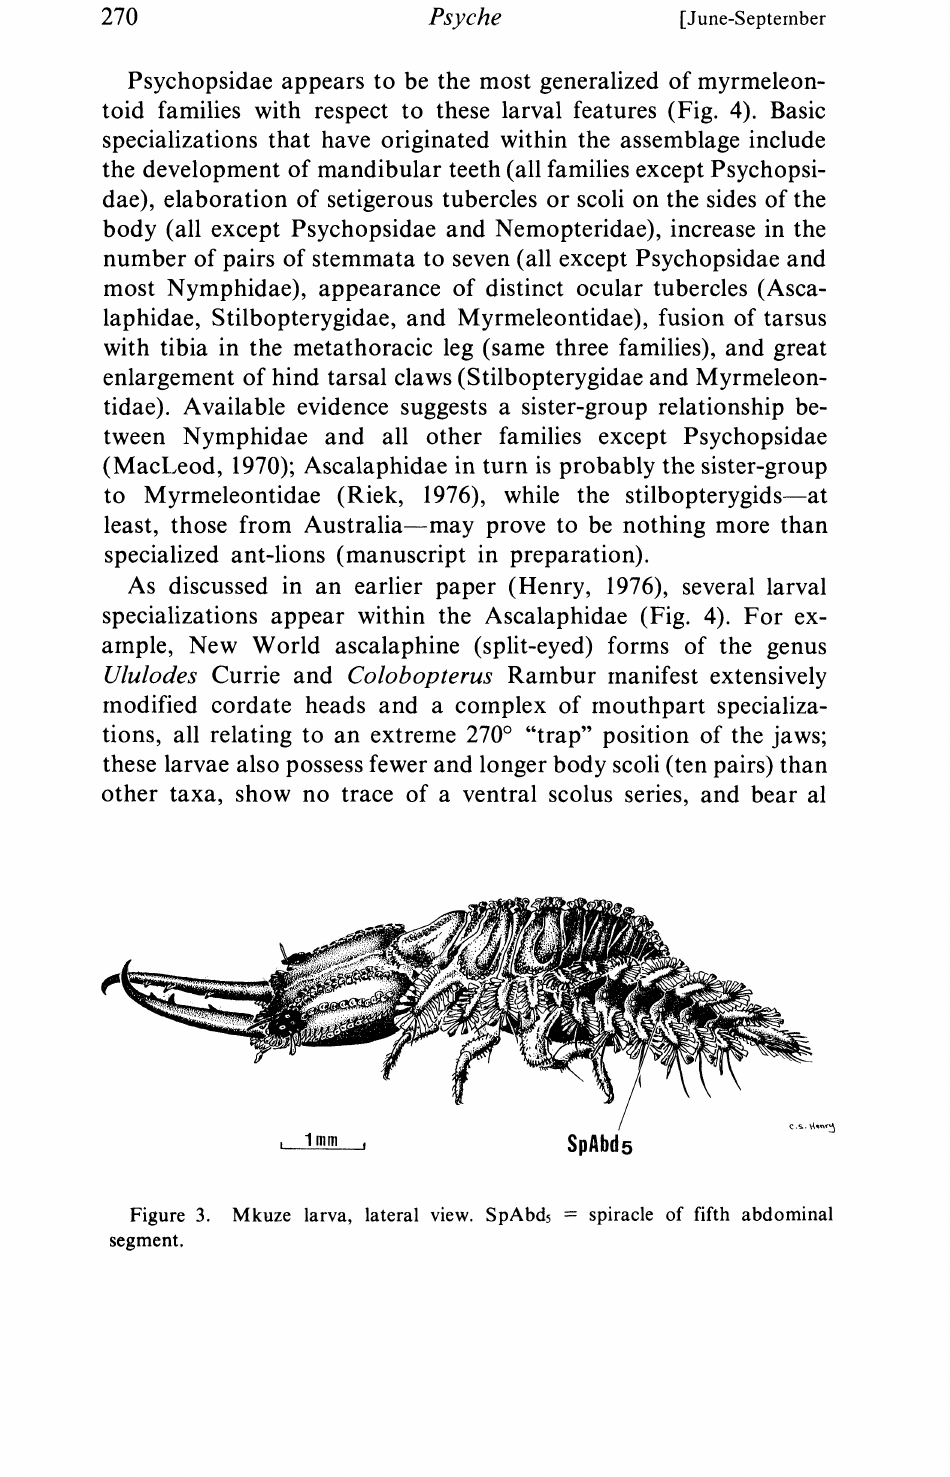
Figure 3. Mkuze larva, lateral view. SpAbd5 spiracle of fifth abdominal